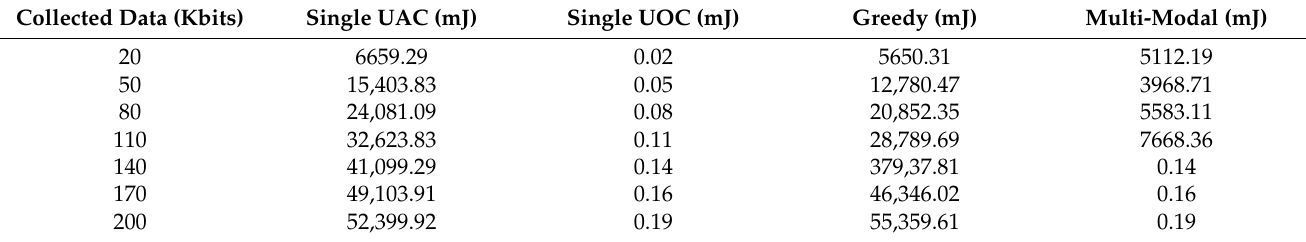
Figure 6. The average AoI of collected data with the increasing data arriving rate. Table 2. Average data transmission energy consumption of CHs versus the data arriving